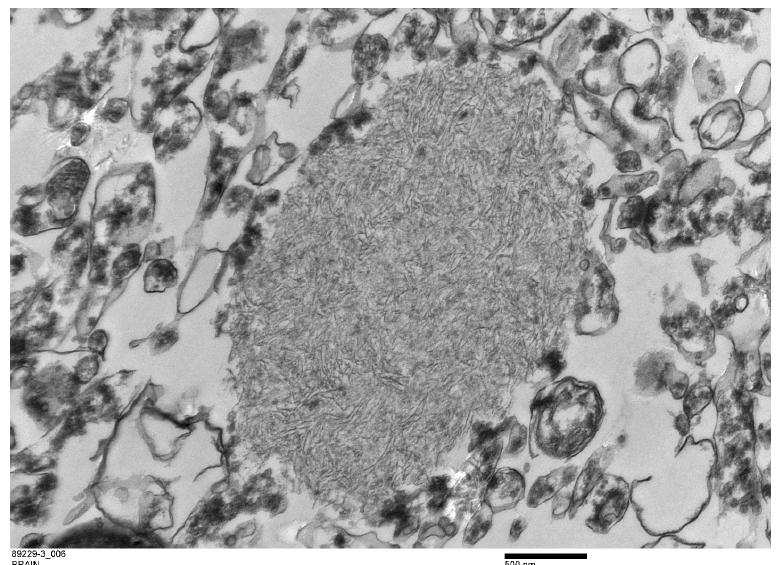
Figure 7. Ultrastructure image showing branched filamentous material in a non-membrane-bound polyglucosan body (PGB). The results of immunohistochemistry using α -synucleins demonstrated numerous intra- and extra-cellular protein aggregates that positively stained with the neurons, glial cells, neuronal process of CA3 and CA4, subiculum, and white matter of the hippocampus of Moose 1 (Table 1; Figure 8). Minimal staining was noted in the subiculum and white matter of the hippocampus Moose 2. (Table 1). PGBs were consistently negative for α - synuclein antibody staining (Table 1). Ultrastructural examination of coarsely granular material stained positive with a Bielschowsky stain, and α -synuclein antibodies (as shown in Figure 8) in the subiculum; white matter of the hippocampus showed membrane-bound inclusions filled with degenerate organelles interspersed with electron dense bodies (neu- romelanosomes), lipid bodies, vesicles, and distorted mitochondria (Figure 9). α -synu- clein-positive areas were negatively stained in a GMS test (data not shown).